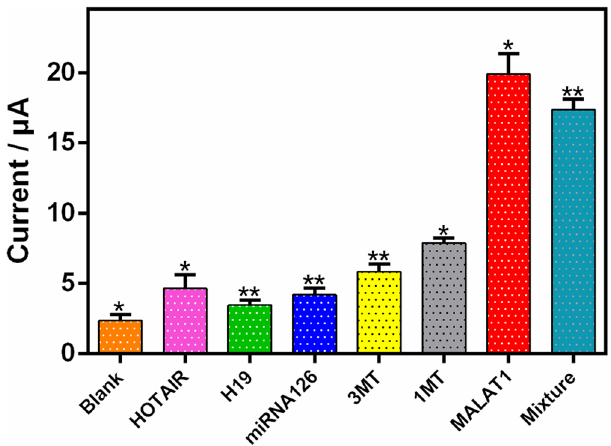
Figure 6. Specificity of the proposed biosensor: different types of sequences (HOTAIR, H19, miRNA126, single-base mismatch target (1MT), three-base mismatch target (3MT), MALAT1, and a MALAT1 mixture); Error bars are related to three independent measurements.